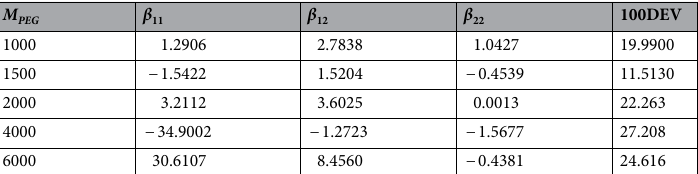
Experimental Calculated